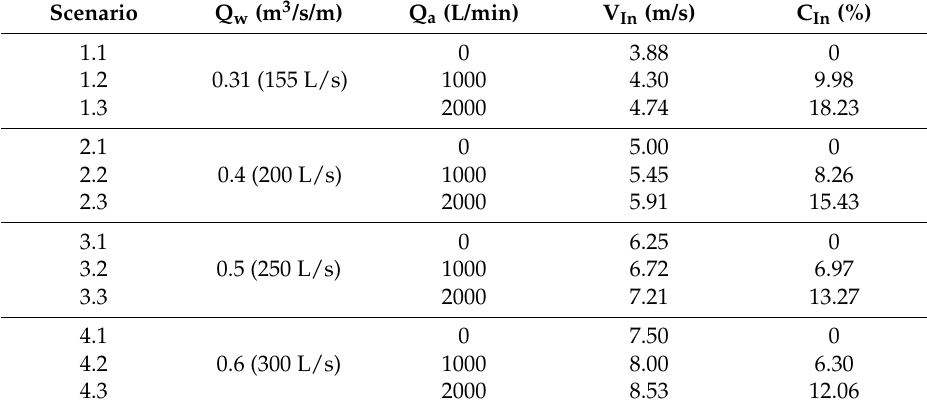
Table 1. Experimental scenarios with average velocity and air concentration at the intake channel.